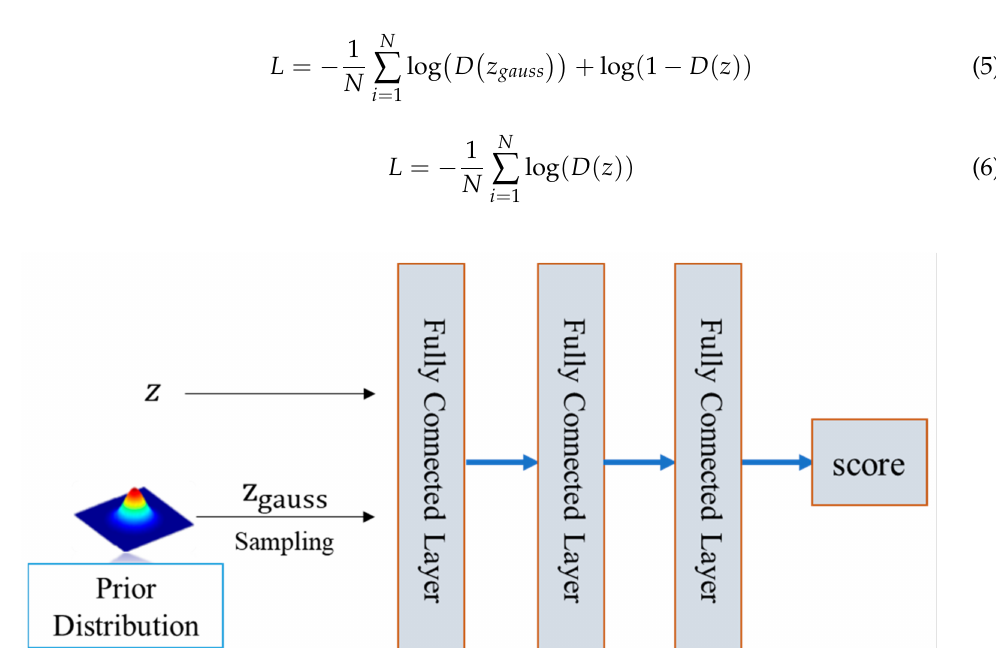
Figure 4. Framework of the discriminator network, where z is the input and the discriminator is used to judge if z matches the priori distribution.